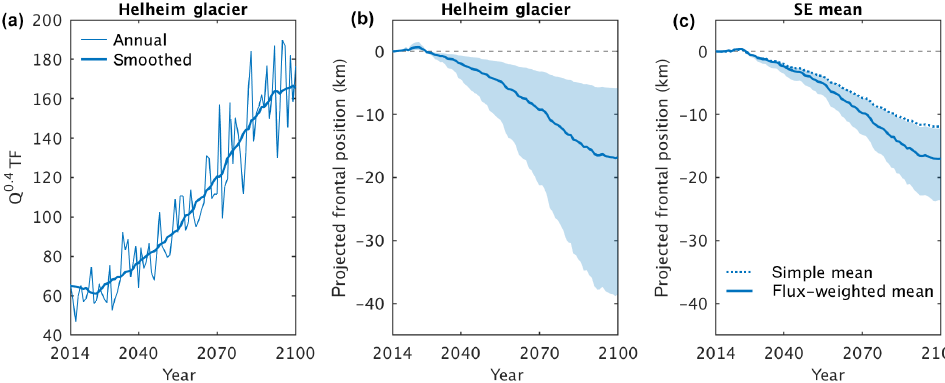
Figure 4. Illustration of retreat implementation processing for MIROC5 under an RCP8.5 scenario. (a) Time series of Q 0 . 4 TF for Helheim Glacier in SE Greenland, showing annual and 20-year centred mean smoothed values. (b) Projected retreat for Helheim Glacier; the solid line is the median retreat while the shading denotes the interquartile range of all 10 4 derived retreat trajectories. (c) Projected retreat for the SE ice–ocean sector. The dotted line shows the median of the trajectories obtained by taking a simple mean over glaciers, while the solid line and shading show the median and interquartile range of the trajectories obtained by taking an ice-flux-weighted mean over